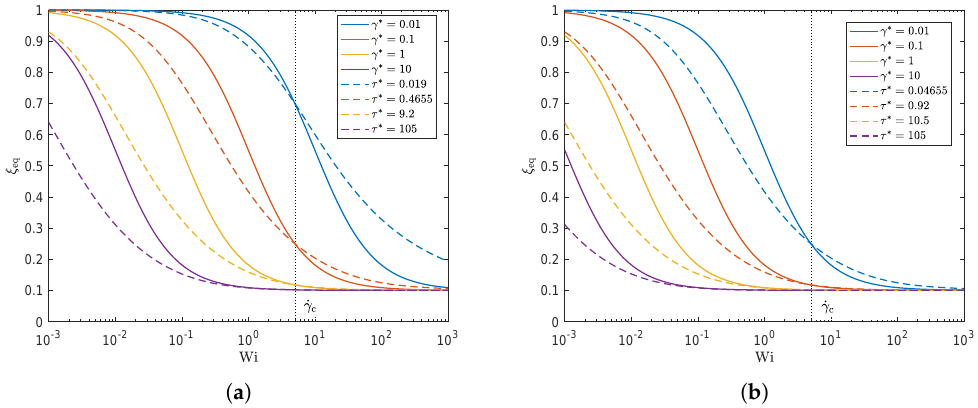
Figure 9. Equilibrium structure parameter ξ eq as a function of Weissenberg number. Here, γ ∗ and τ ∗ are chosen such that ξ eq is matched for the rate and stress-controlled approach at a characteristic shear rate ˙ γ c . ( a ) λ θ = 10 λ avg . ( b ) λ θ = 100 λ avg . The damage parameters used in this paper to compare the stress and rate-controlled approach are given in Table